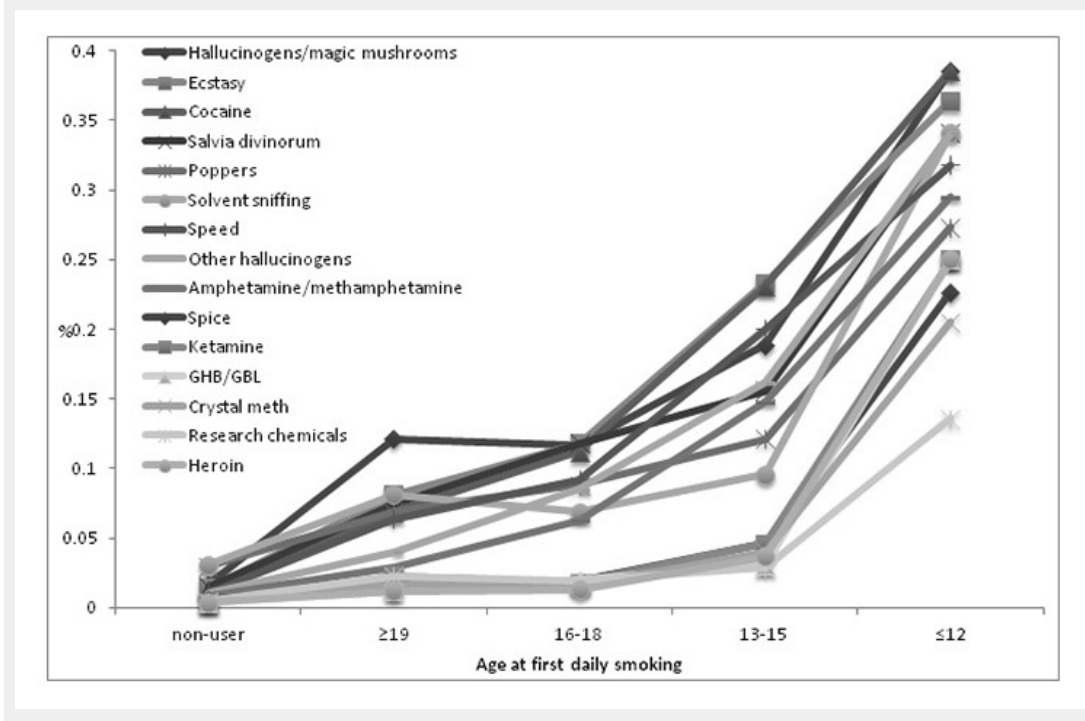
Figure 4 Prevalence rate of drug use according to age at first daily smoking. The prevalence rate for each drug is given according to the age of onset of daily smoking. For example, 25.0% of the participants who smoked daily at age 12 years or earlier used heroin, whereas only 3.7% of the participants who smoked daily at age 13 to 15 used heroin (percentages can be found in table